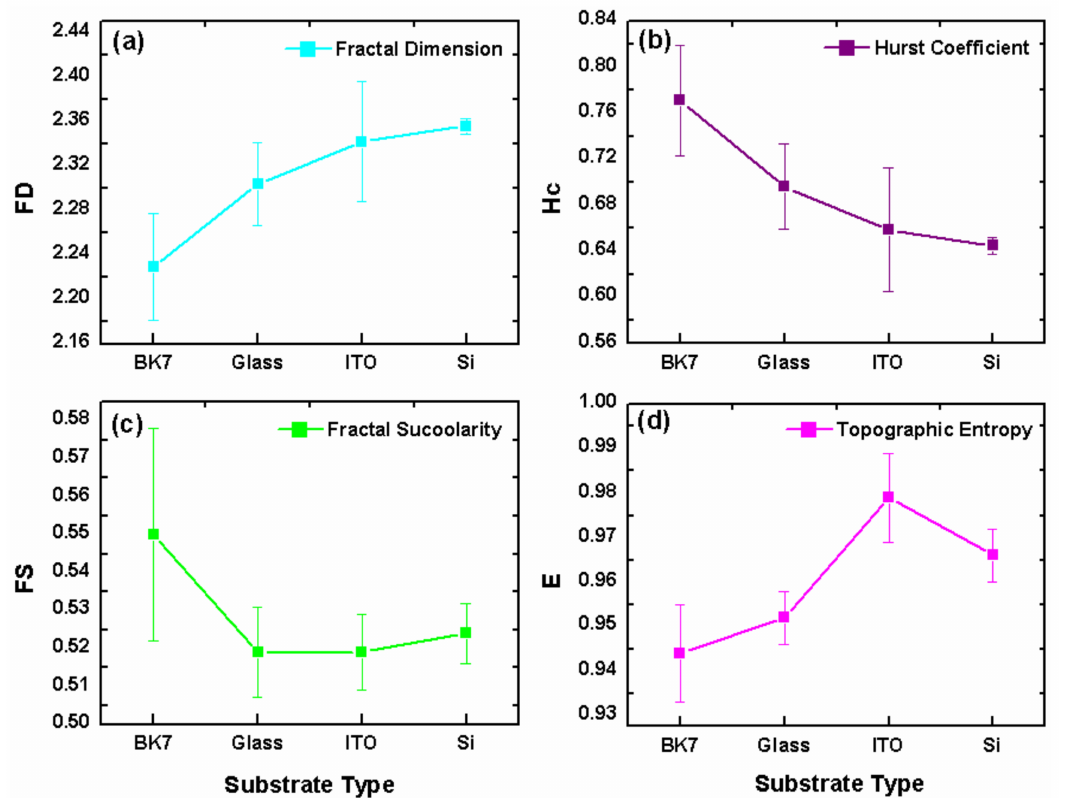
Figure 5. Fractal-related parameters of Cu/Cr films deposited on ( a ) BK7, ( b ) Si, ( c ) Glass, and ( d ) ITO